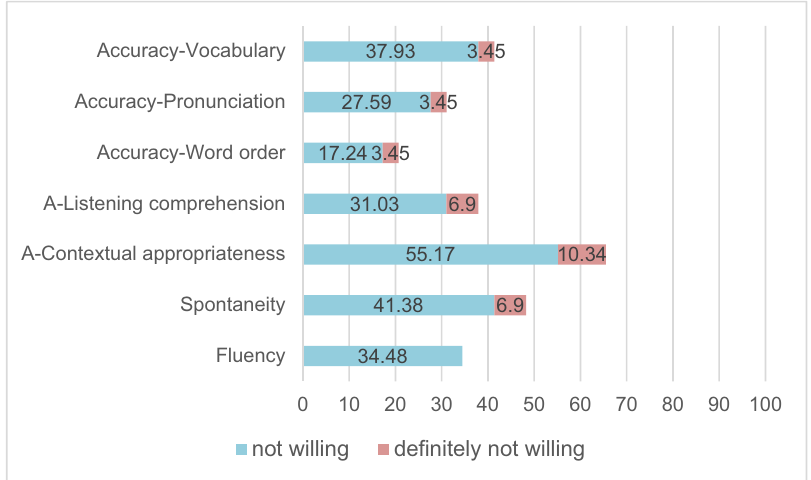
Figure 9: Unwillingness rates under anxiety about L2 English abilities ( % )